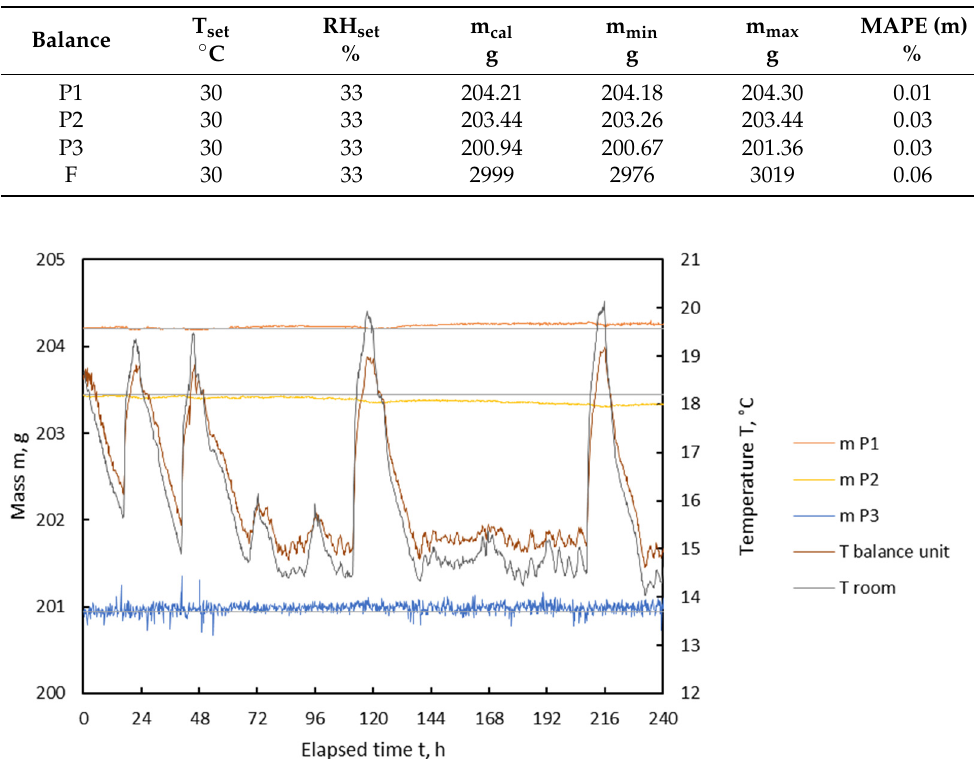
Figure 6. Temperature and mass vs. time; room temperature (T room ), temperature in balance unit (T balance unit ) and sample mass of precision drying zone (m P1 , m P2 , m P3 ) in the HPD TF3+ during calibration.